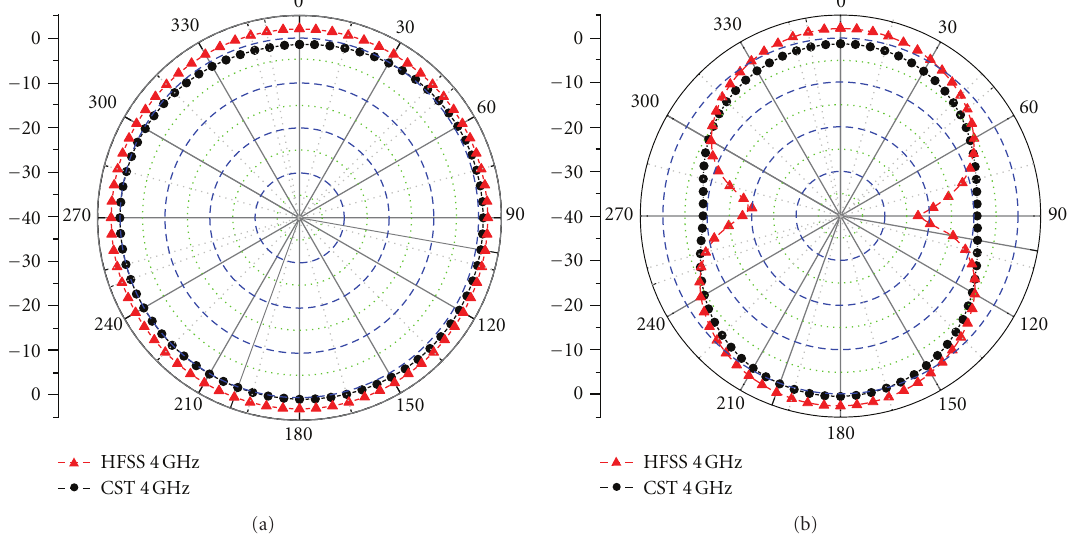
Figure 8: Radiation patterns of the proposed antenna at 4 GHz; (a) xoz-plane, (b)